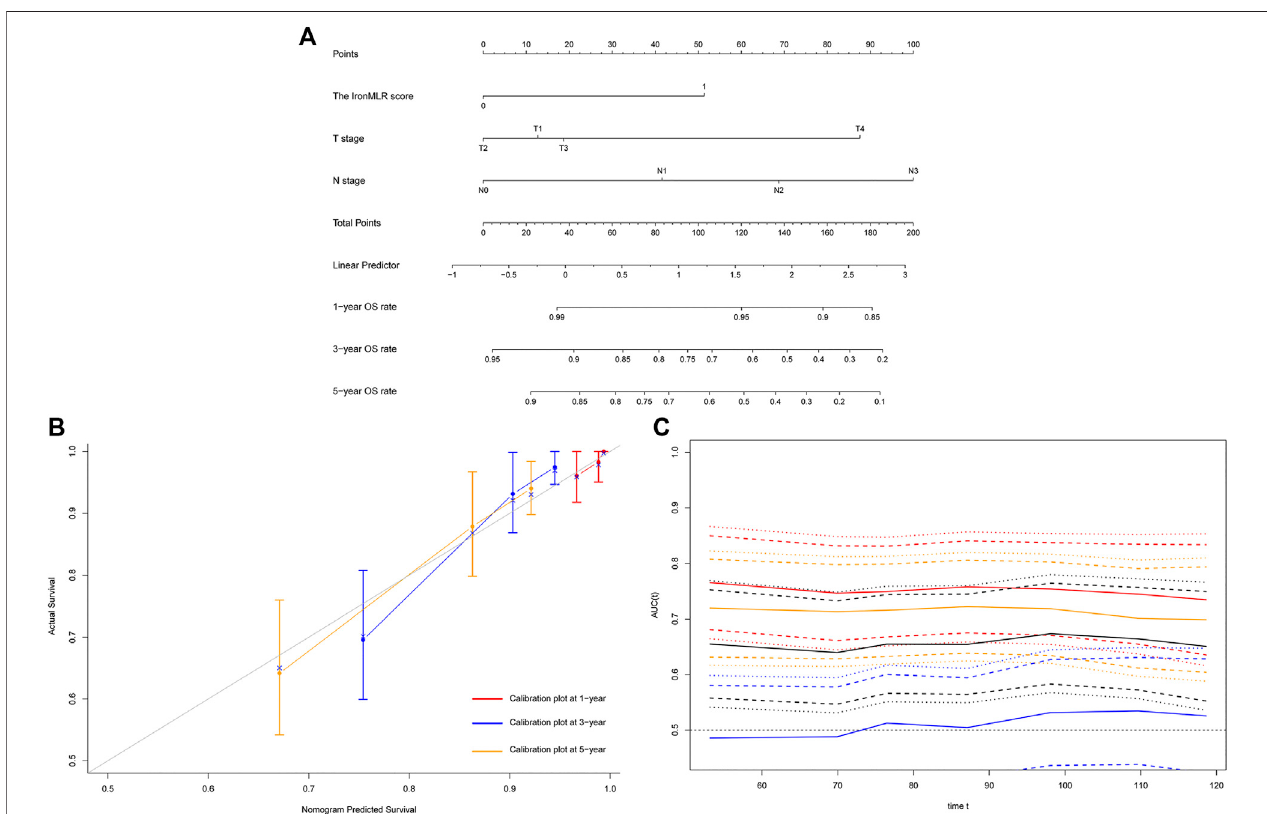
FIGURE 4| Development and evaluation ofa model for individualized prediction ofoverall survival (OS). (A) Nomogram of prognostic model for patientswith early- stage triple-negative breast cancer. (B) Calibration plots for predicting OS at 1-, 3-, and 5-years. (C) Time-dependent receiver operating characteristic (ROC) curves (Nomogram [red], T stage [blue], N stage [orange], TNM stage [black]).